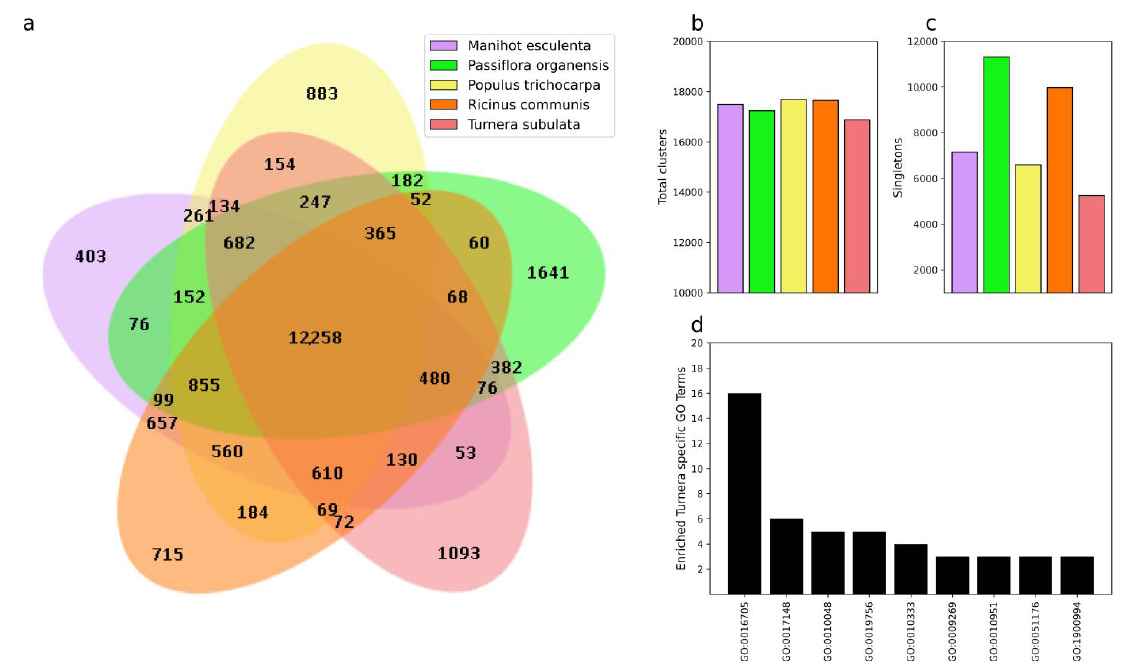
Figure 3. OrthoVenn2 results of the Malpighiales comparison. Venn diagram showing orthologous groups shared between various combinations of the five species as well as proteins that were specific to a single species ( a ). Total number of clusters for each species including both orthologous and paralogous clusters ( b ). Total singletons for each species; these represent proteins that are predicted to not share a similar function with other orthologs or paralogs ( c ). Enriched GO terms for Turnera specific paralogous groups ( d ).